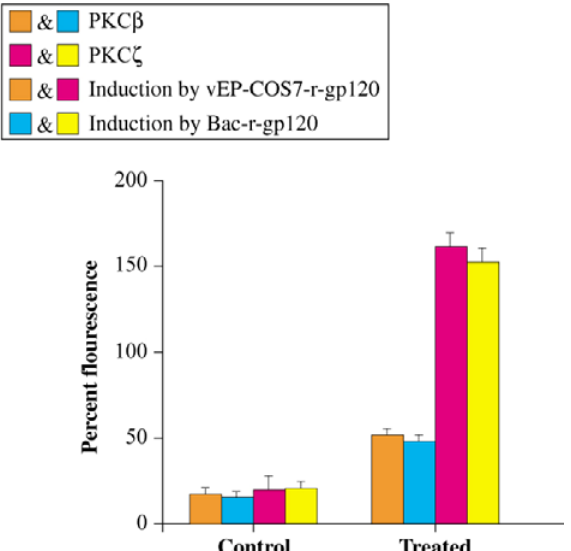
Figure 4. Effect of stimulation of astrocytes with recombinant gp120 on PKC β and PKC ζ . PMA or full-length recombinant gp120 produced from vaccinia-infected COS-7 cells (vPE8-COS7-r-gp120) or by insect cell/baculovirus system (Bac-r-gp120) was applied to rat astrocytes. PKC isozyme activity is presented as a percentage of the activity induced by PMA. Each bar represents a mean of five assays. Both protein preparations stimulated PKC to a similar level. PKC ζ response was significantly (P<0.05) higher than that of PKC β .